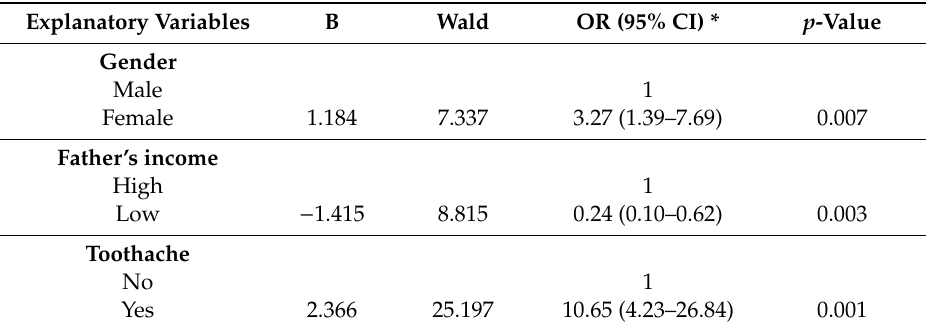
Table 3. Results of multivariable logistic regression of the association between C-OIDP ∞ and explanatory variables among children in Madinah, SA ( n =